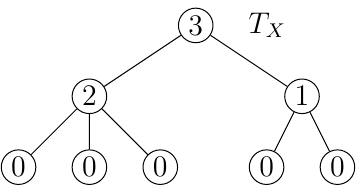
(cid:8) (cid:9) { x , x } , 1 2